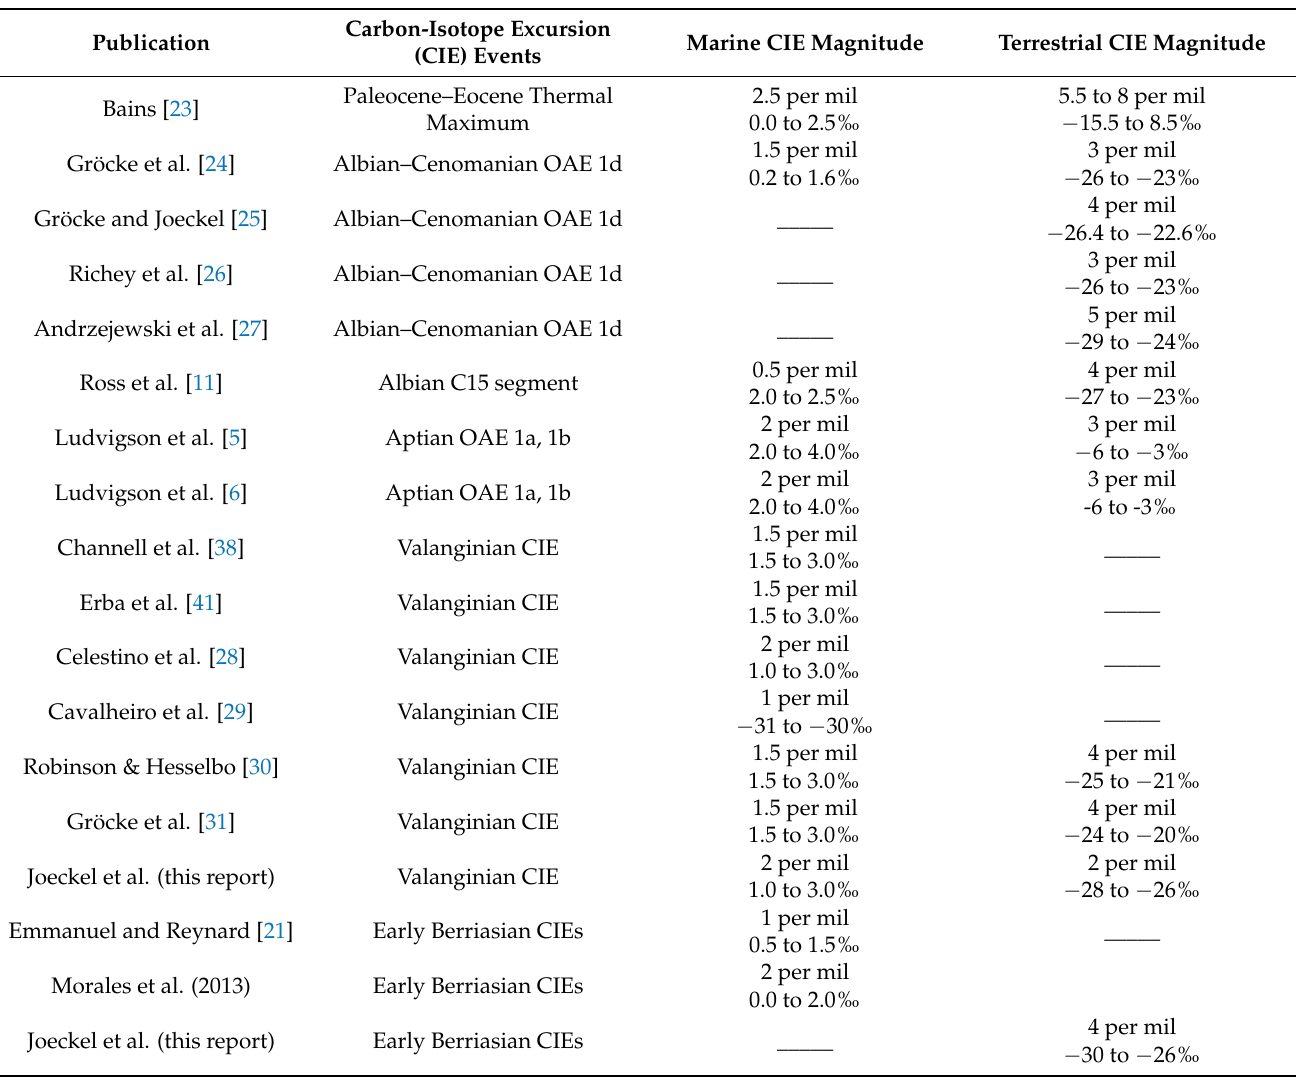
Table 3. Comparison of magnitudes of published marine and terrestrial records of well-known Cretaceous and Paleogene carbon-isotope excursions (CIEs), exemplifying comparative differences in the magnitudes. See text for further